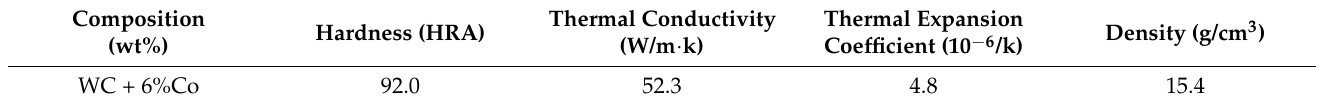
Table 1. Composition and physical parameters of the selected cemented carbide.